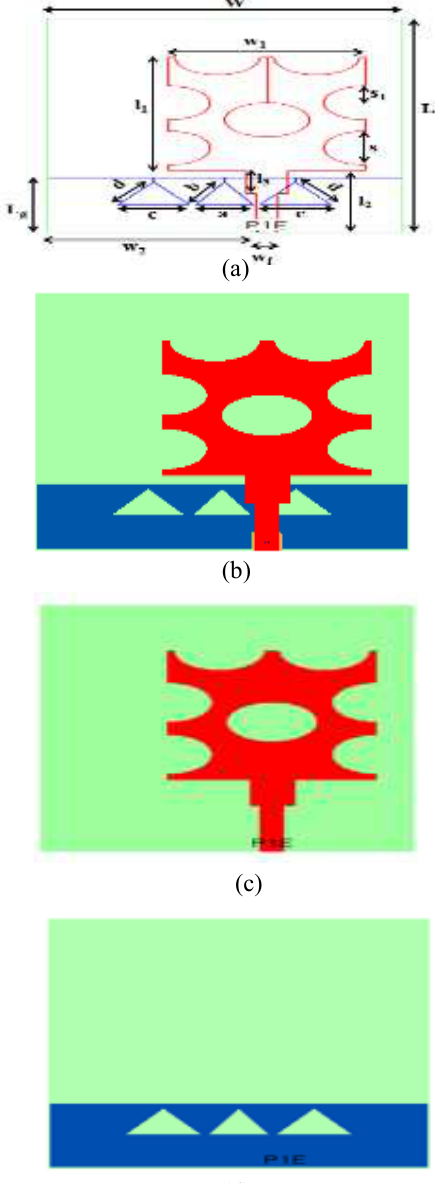
Figure 1: (a) Proposed antenna design configuration (b) 3-D view (c) Top view (d) Bottom